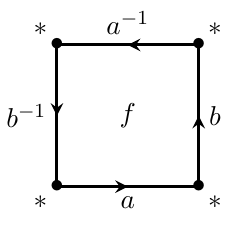
Figure 16 . A decomposition of the 2 -torus. In this case we have ∂f = b − 1 a − 1 ba